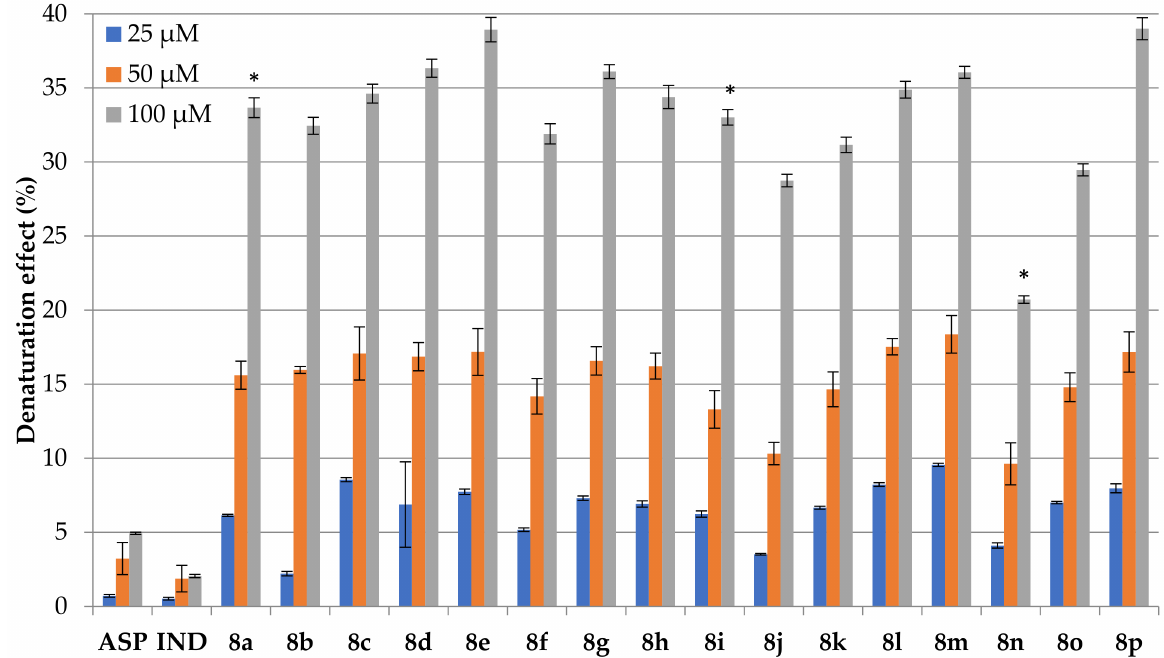
Figure 5. The effects of NO-IND-OXDs ( 8a–p ) and of reference drugs (IND, ASP) on BSA denaturation process (* 8n < 8a and 8i , p <